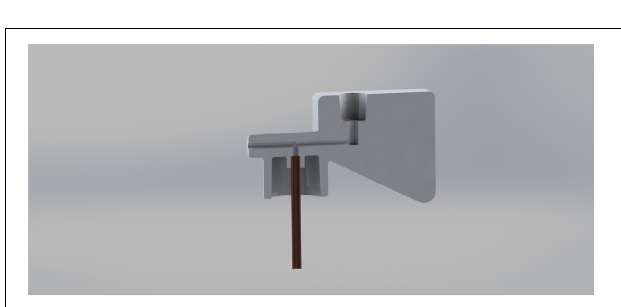
FIGURE 2 | Cross section of a digitally designed inoculator used in handling cereal rust urediniospores.